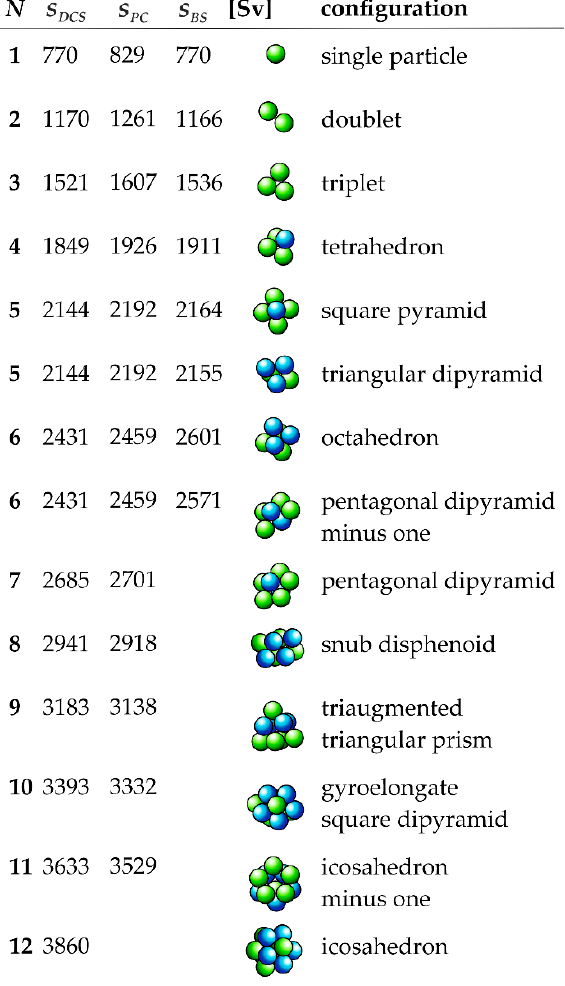
Figure 3. Sedimentation coefficients of the cluster species varying in the number of constituent spheres N and, consequently, their configurations. Analytical values s DCS obtained from DCS are compared with sedimentation coefficients S PC estimated from preparative separations by rate-zonal density gradient centrifugation. In addition, sedimentation coefficients S BS predicted from hydrodynamic bead-shell modeling, as taken from [16], are given for clusters with N ≤ 6. Model building considers the exact geometries of the colloidal clusters. Notwithstanding the shortcomings in deriving sedimentation coefficients from preparative centrifugations, the quantities thus obtained differ by less than 8% from the analytical values and the theoretical predictions.